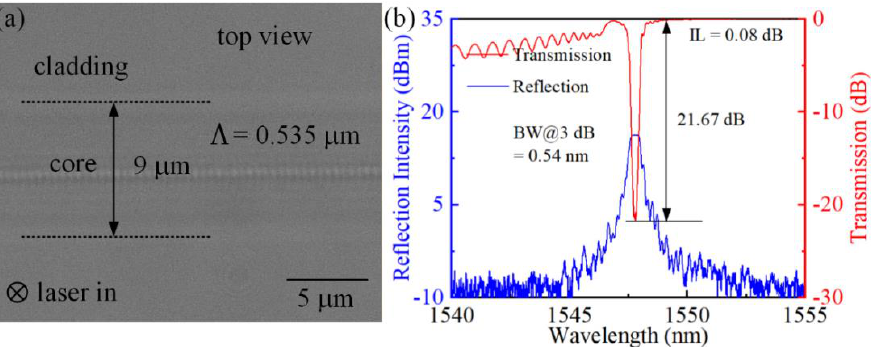
Figure 4. ( a ) Top-view morphology of the inscribed first-order FBG and ( b ) corresponding transmission and reflection spectra.